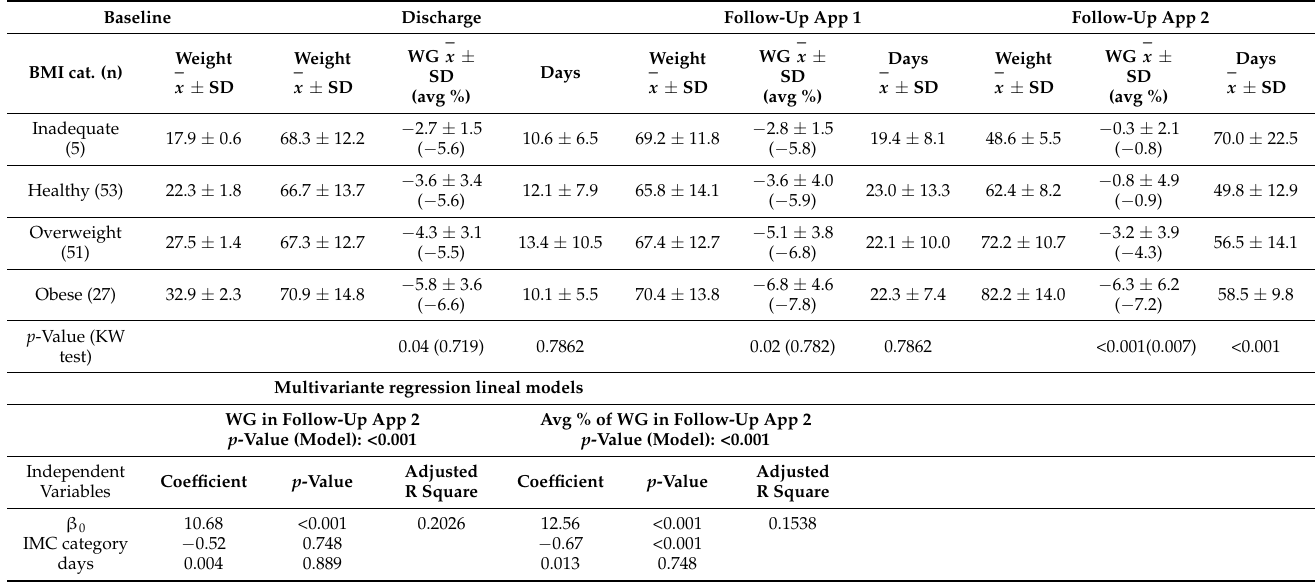
Table 4. Analysis of the weight